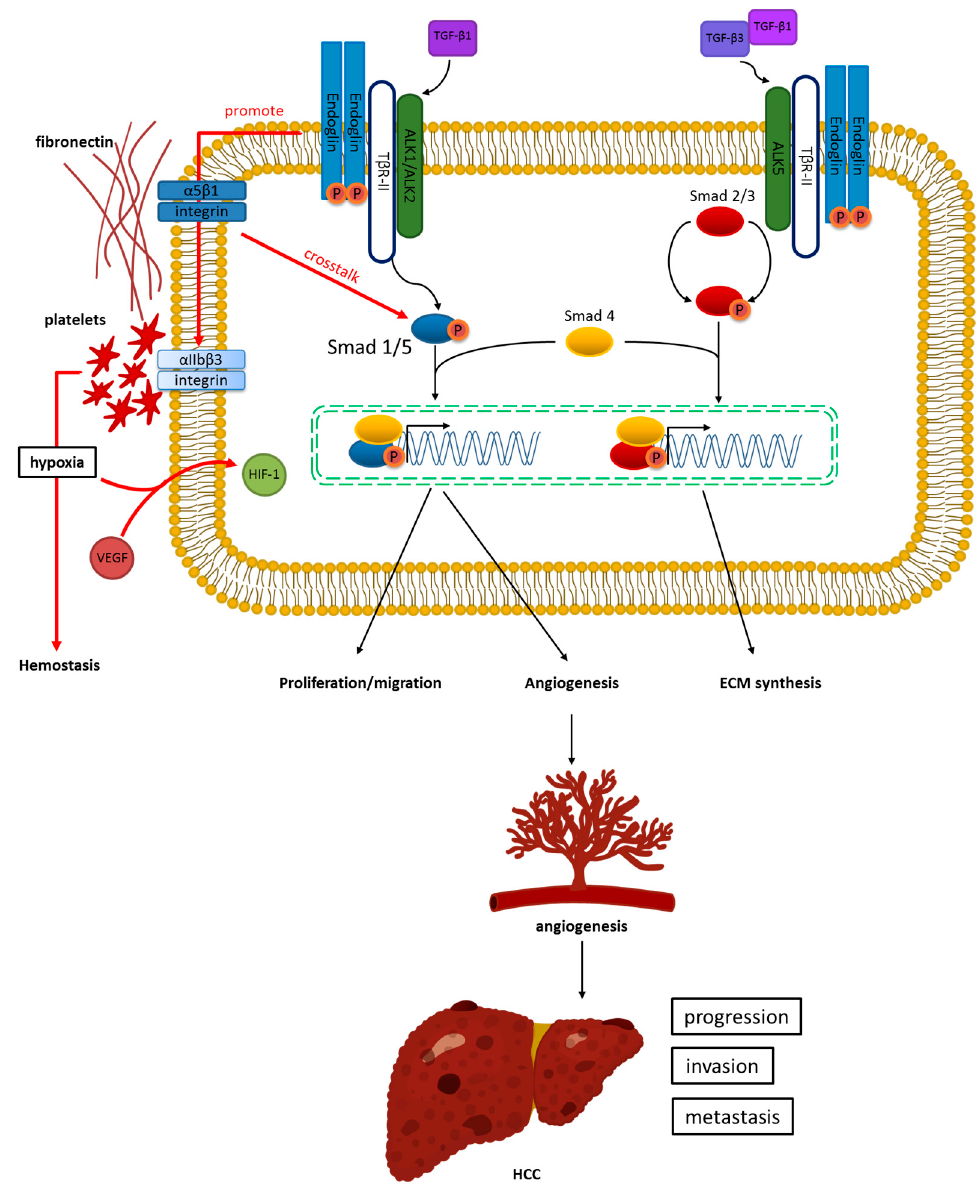
Figure 1. Endoglin and transforming growth factor- β (TGF- β ) signaling in hepatocellular carcinoma (HCC). Endoglin binds to TGF- β 1 by linking with TGF- β type II receptor activin receptor-like kinase 1 (ALK1). This leads to downstream SMAD family member 1/5 (SMAD1/5) phosphorylation with SMAD4, increasing EC proliferation, migration, and angiogenesis. This process results in HCC progression, invasion, and metastasis. In addition, endoglin-mediated fibronectin/ α 5 β 1 integrin demonstrates crosstalk with the TGF- β pathway to facilitate capillary stabilization and increase angiogenesis. Conversely, endoglin binds to TGF- β 1/3 by associating with TGF- β type II receptor (ALK5). This behavior activates SMAD2/3 phosphorylation with SMAD to promote extracellular matrix (ECM)